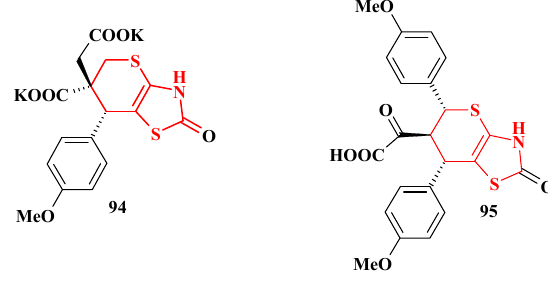
Figure 3. Thiopyrano[2,3- d ]thiazoles as potenstial NSAIDs.